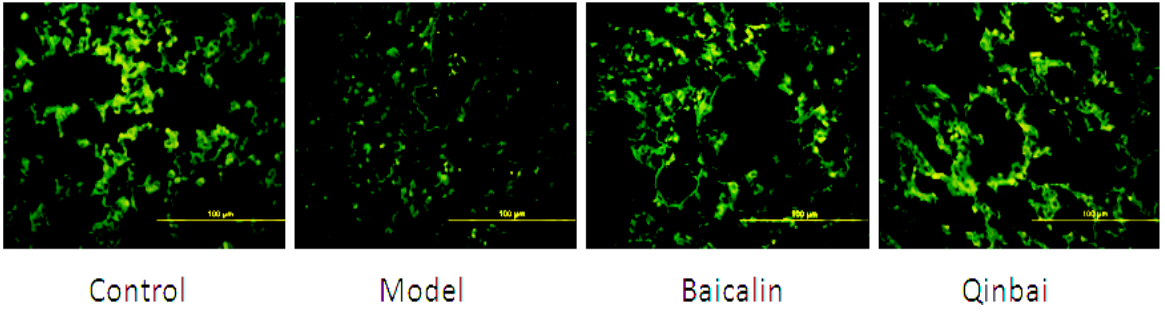
Figure 7. The treatment of BALB/c mice with Baicalin or Qinbai led to an increase in EGF protein expression according to immunofluorescence results. Experiments were repeated twice.